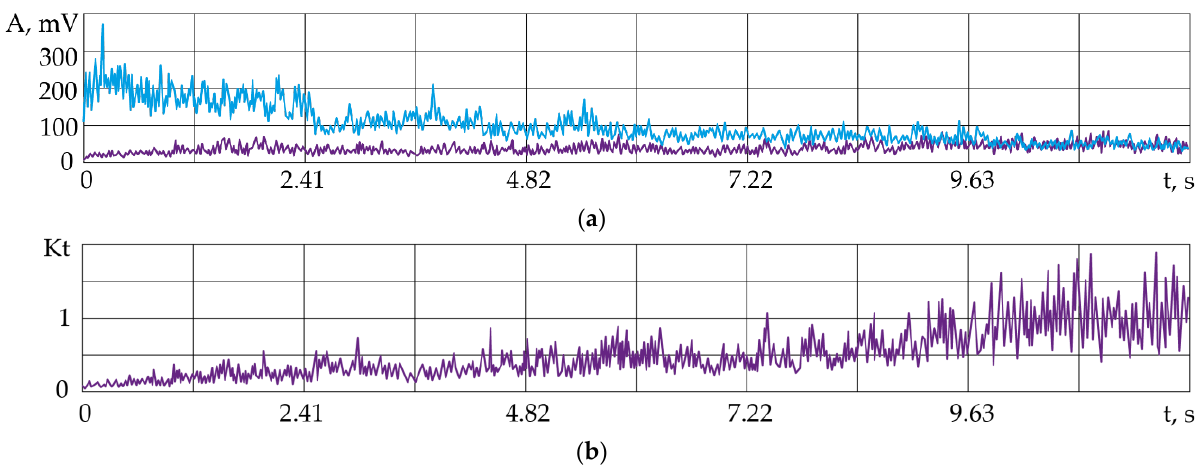
Figure 6 . RMS amplitudes of the AE signals during the solid carbide segment in the frequency ranges. Curve 1: 1 – 3 kHz, curve 2: 10 – 20 kHz ( a ); curve 3: the change in the ratio of lf to hf amplitudes (coefficient Kf) ( b ).